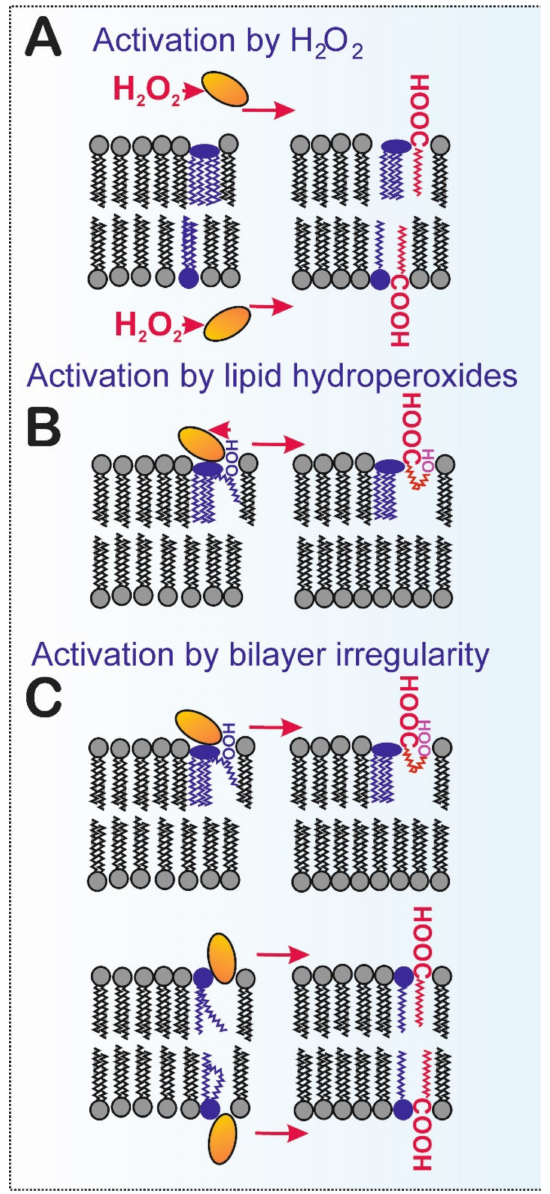
Figure 4. Identified mechanism and hypothetical alternative pathways of iPLA2 γ activation. The pos- sible direct redox and indirect redox mechanisms are illustrated. ( A ) Direct activation by H 2 O 2 was demonstrated by using recombinant iPLA2 γ reconstituted in phospholipid vesicles [19] and isolated rodent mitochondria [17,18]; ( B ) activation by cardiolipin hydroperoxides. Lipid hydroperoxides and other lipophilic electrophiles could hypothetically interact with the accessible redox-sensitive site similarly to an H 2 O 2 molecule, leading to direct oxidation of iPLA2 γ thiols [40]. ( C ) Hypothet- ical activation by structural alteration(s) of the lipid bilayer, caused, for example, by cardiolipin hydroperoxides without direct oxidation of iPLA2 γ . These alterations can further be caused by polyunsaturated fatty acids and even hydroxy or peroxy groups existing in phospholipid fatty acyl side-chains and localized at the water/lipid